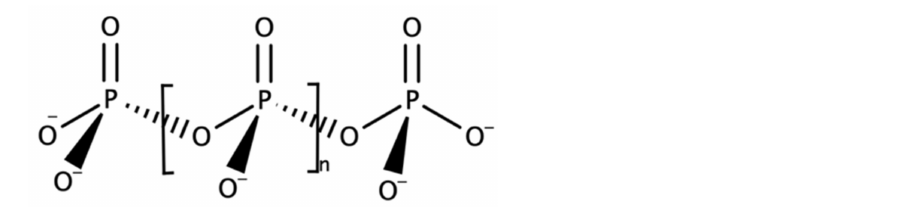
Figure 18. Basic molecular structure of polyphosphate, where n is the number of repeating